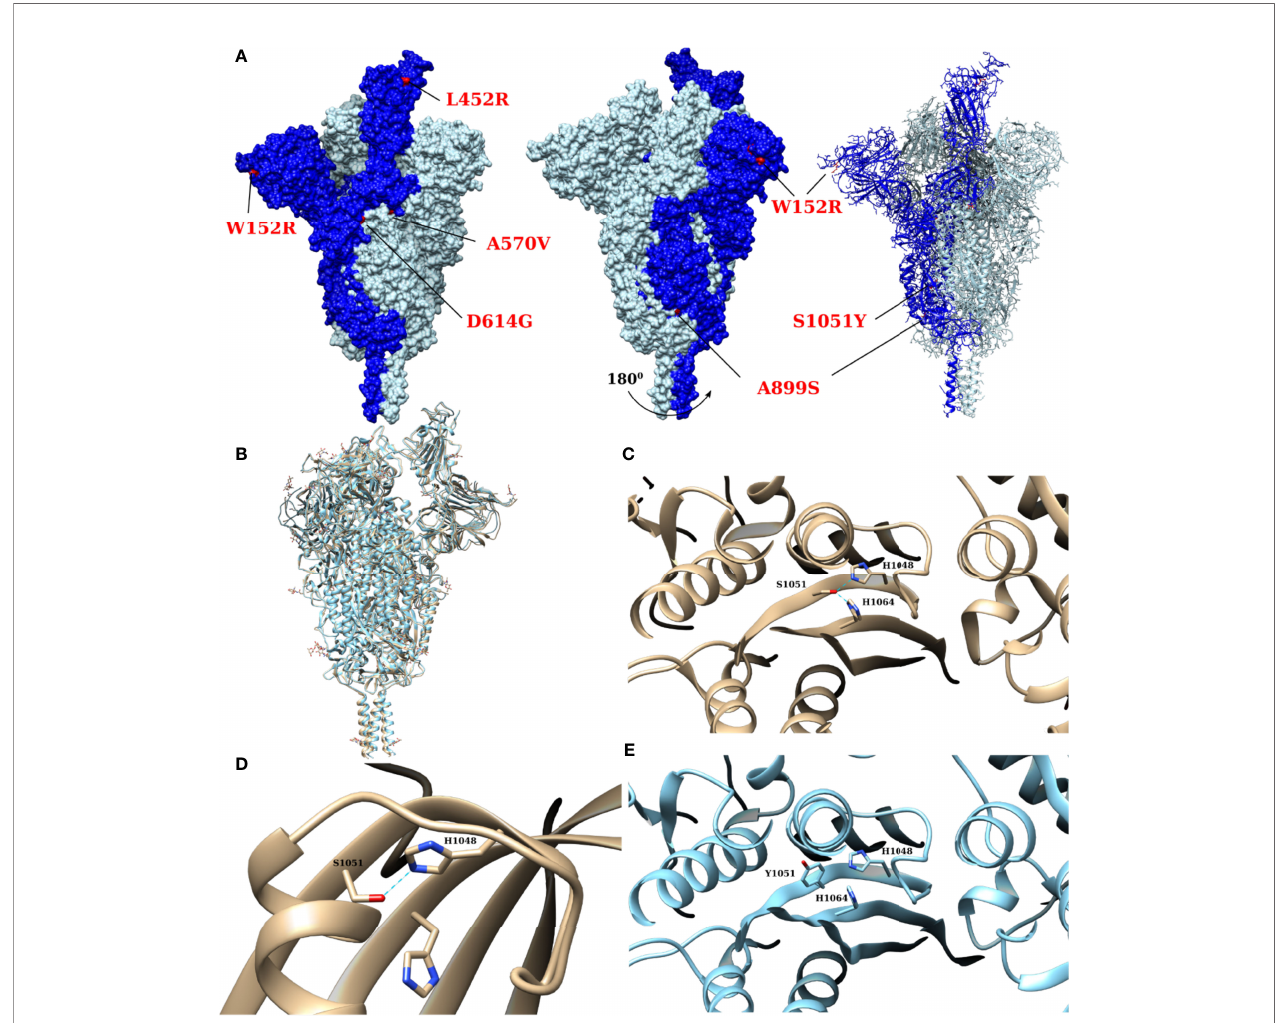
FIGURE 4 | The overall distribution of the spike protein mutations observed in the studied sequences and the impact of (S1051Y) mutation on its structure and function. (A) shows the overall distribution of the mutations, found in the sequenced samples in this study, mapped onto the predicted structure by homology modelling. The mutated residues in one monomer are depicted in red and the monomer with RBD-up is depicted in dark blue. The isosurface of the trimer is shown on the left and a rotated view (by 180 ◦ ) of the latter is shown in the center, while the atomic details are shown on the right. (B) illustrates the predicted structure of the sequence presented in this study, depicted in light blue, superposed onto the template used to generate it (depicted in gold, derived from PDB ID 7krr). (C – E) illustrate molecular details of the impact of (S1051Y) on the structural stability and function of spike protein. In the presence of the native serine 1051 (PDB ID 7krr), the residue interacts with two histidine residues (His 1048 and His 1064), as illustrated in (C) (top view, showing hydrogen bonds depicted by the cyan lines) (Zhang J et al., 2021). Such interactions are likely to stabilize the beta-sheet within the native conformer. These interactions are likely to be abolished by the mutation (S1051Y), as shown in the predicted model by homology modelling (E) . (D) shows the interaction of the serine and the two histidine residues in the unmutated post- cleavage structure [PDB ID 6xra (Cai et al., 2020)]. The fi gure illustrates that post-cleavage structural changes in the protein lead to bond break between the serine residue and His